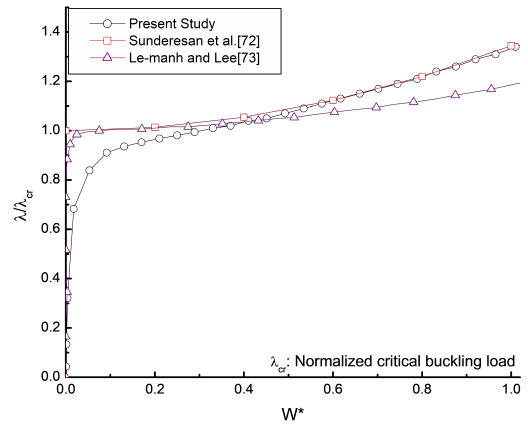
Fig. 7: Validation of buckling and postbuckling behavior of all edges simply-supported isotropic and homogeneous plate under uni-axial